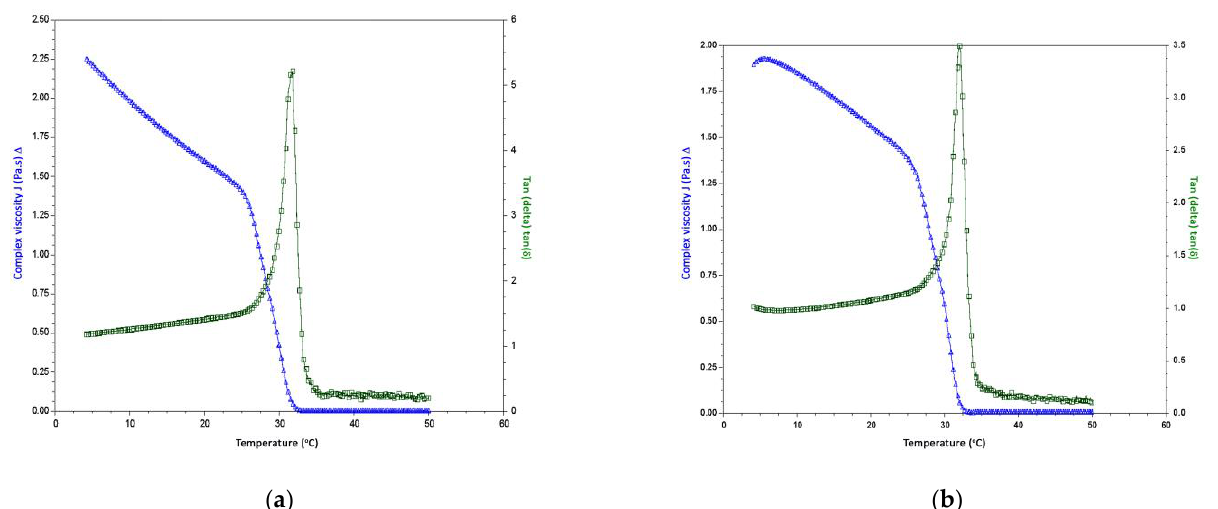
Figure 5. Temperature dependence of complex viscosity ( η *) and tangent (tan δ ) of silver catfish collagen at ( a ) 24 h and ( b ) 48 h extraction time.